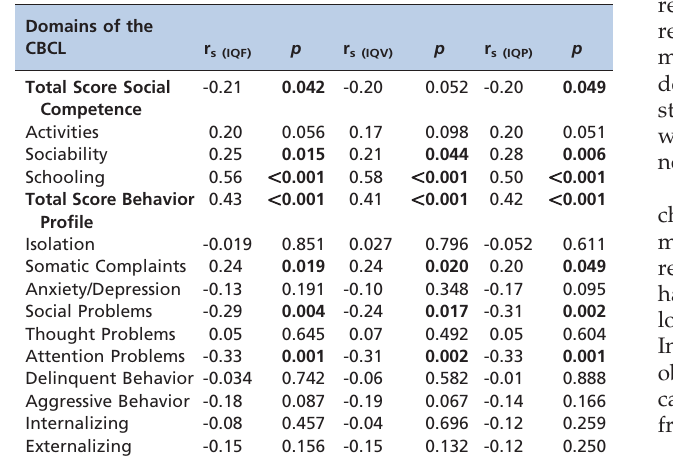
Table 3 - Correlation between the Wechsler intelligence scale for children (WISC-III) and the various domains of the Child Behavior Checklist (CBCL).